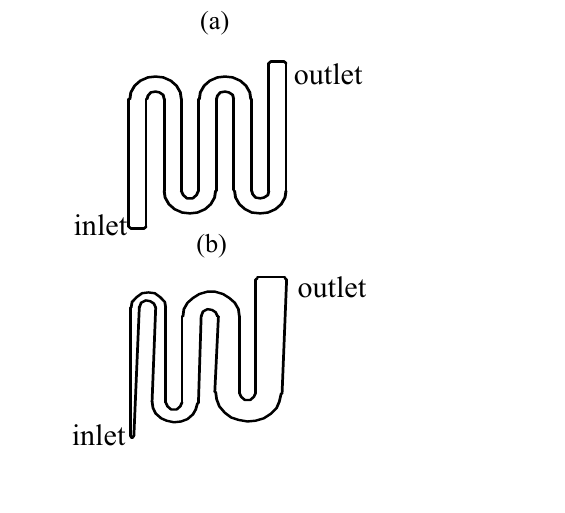
Table 1. Geometry of the flow